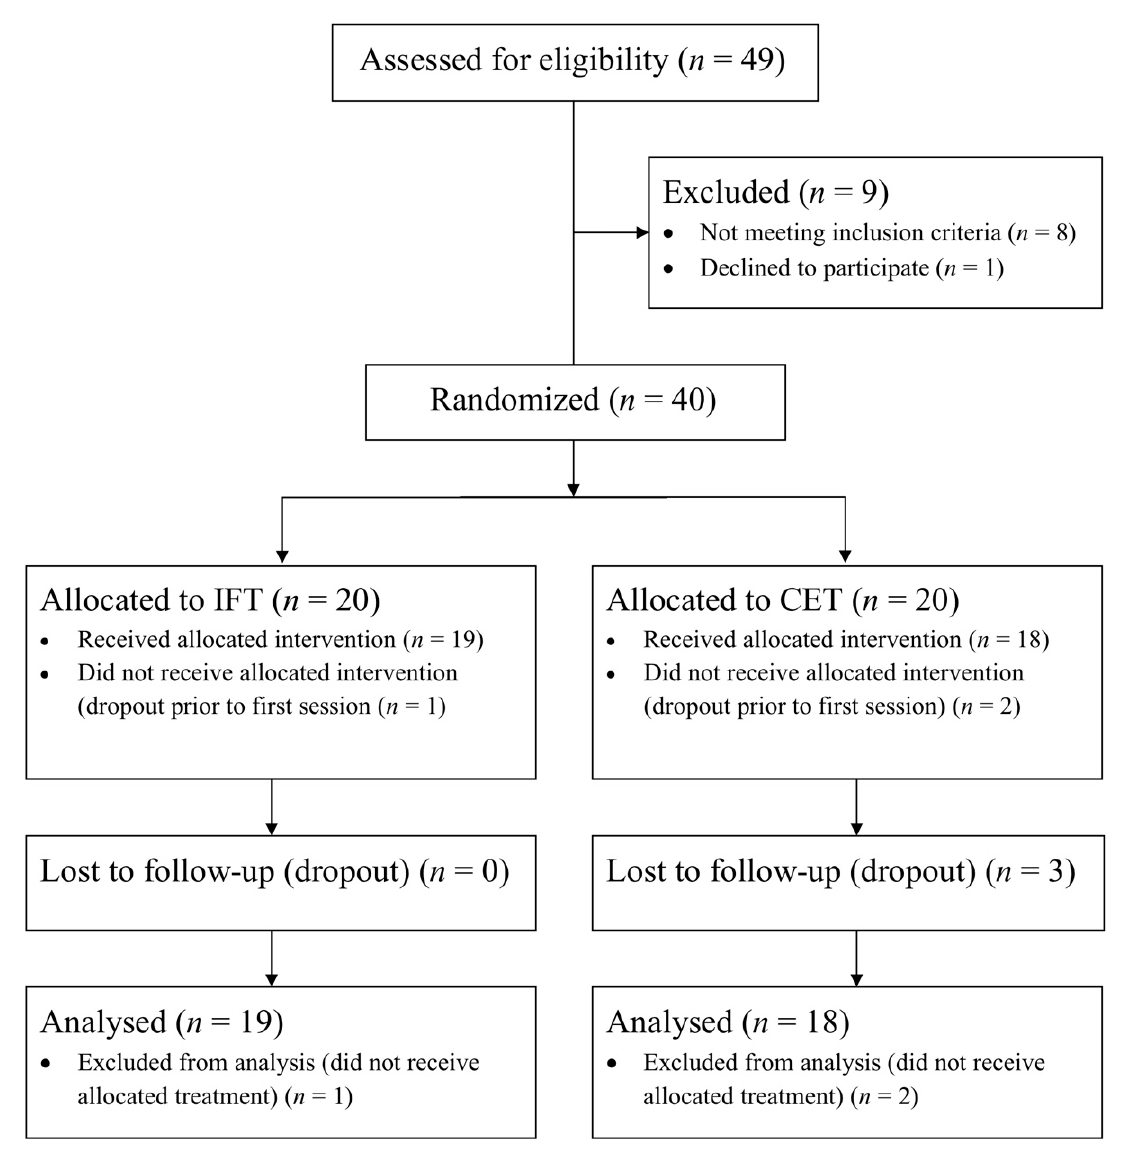
Figure 1. Participant flow through each stage of the study. Table 1. Baseline Characteristics.